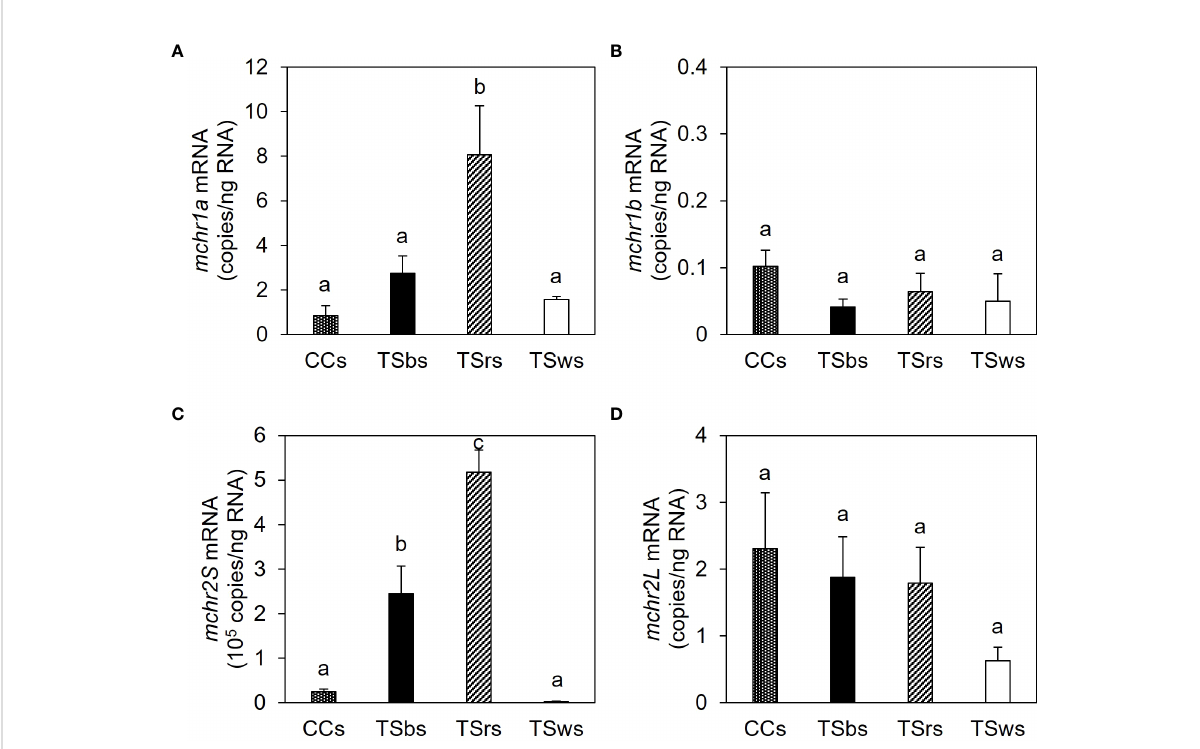
FIGURE 7 Expression of melanin-concentrating hormone receptor ( mchr) mRNA in the scale. The mRNA levels of mchr1a (A) , mchr1b (B) , mchr2S (C) , and mchr2L (D) in the dorsal skin of common carp (CCs) and black-, red- and white-colored dorsal skin of TS (TSbs, TSrs, and TSws, respectively). Data are shown as mean ± SE. Different letters indicate statistically signi fi cant differences estimated by ANOVA followed by Tukey ’ s HSD test; P < 0.05, n =